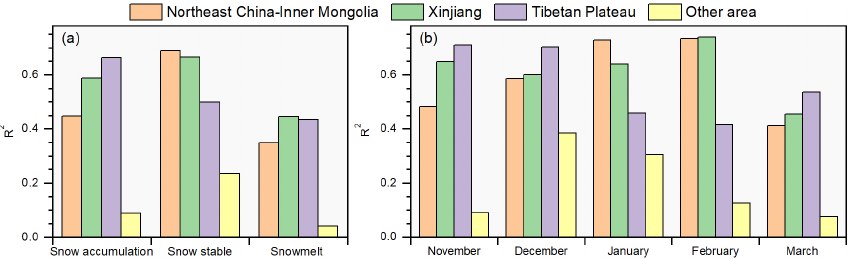
Figure 6. Accuracies of snow density estimation in different snow periods (a) and months (b) over different snow cover regions. Table 2. Accuracies of various regression models for estimating daily snow density. Model Full name of model Slope R 2 RMSE MAE R Multiple linear regression 0.783 0.015 0.060 0.044 GWR Geographically weighted regression 0.069 0.022 0.143 0.091 GTWR Geographically and temporally weighted regression 0.398 0.271 0.070 0.043 GRNN General regression neural network 2.394 0.033 0.062 0.046 GWNN Geographically weighted neural network 0.489 0.124 0.062 0.043 GTWNN Geographically and temporally weighted neural network 0.906 0.531 0.043